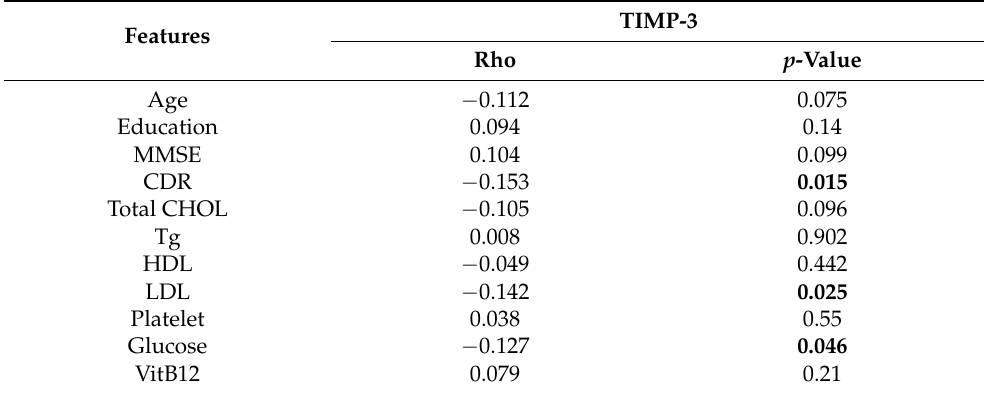
Figure 3. Analysis of TIMP-3 levels in human plasma. Plasma TIMP-3 concentrations were measured by ELISA. The differences in the relative amounts of TIMP-3 were compared between dementia, MCI, and controls using the Mann-Whitney U-test within different groups. NS = not significant. Table 2. Correlations between plasma biomarkers and baseline characteristics.